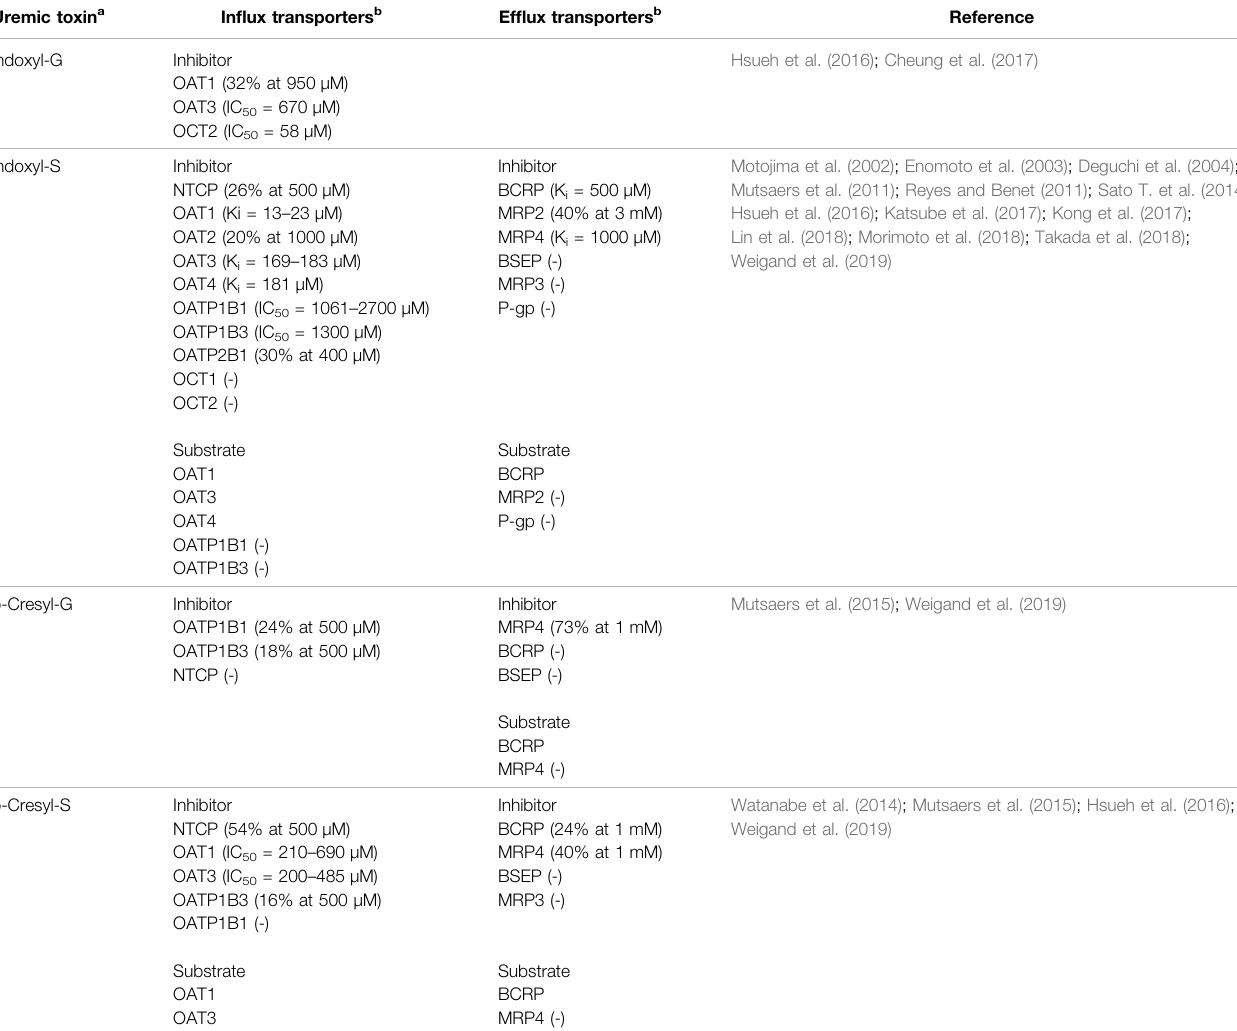
TABLE 3 | Interaction of drug transporters with uremic toxins in transporter overexpression systems. Uremic toxin